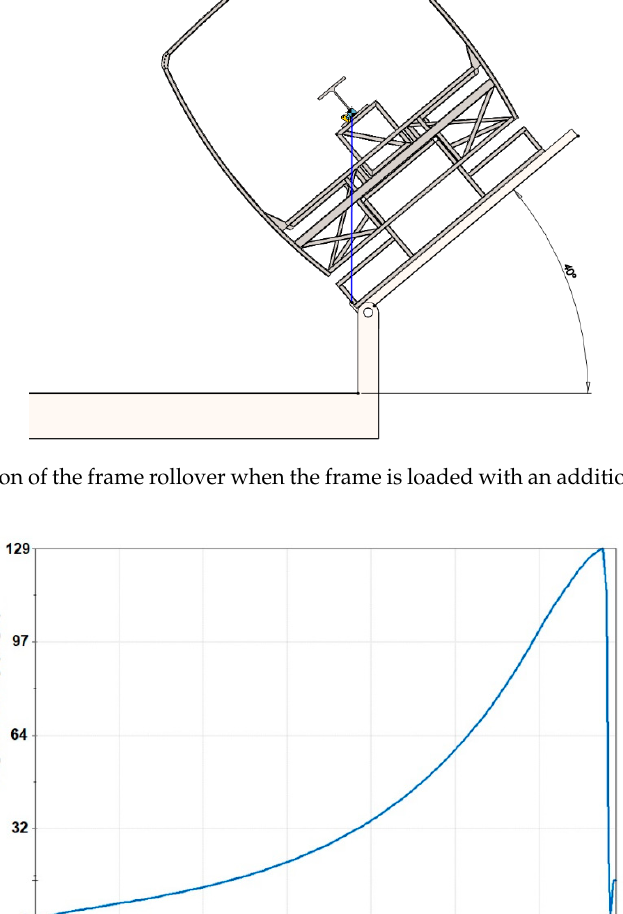
Figure 6. The alteration of the angular velocity of the safety frame around the rollover axis before the impact.